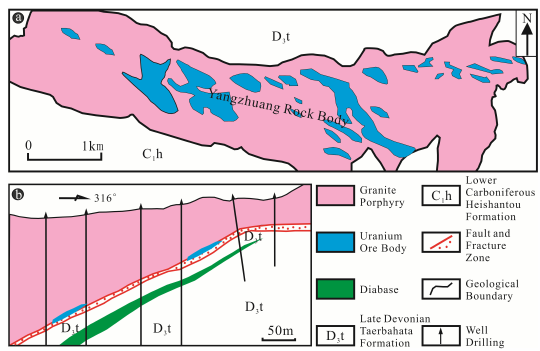
Figure 3. ( a ) Planar distribution of the uranium ore body in the Baiyanghe Uranium deposit. ( b ) Uranium ore body’s position in a geological cross section (modified after [3,24] and Geological Team